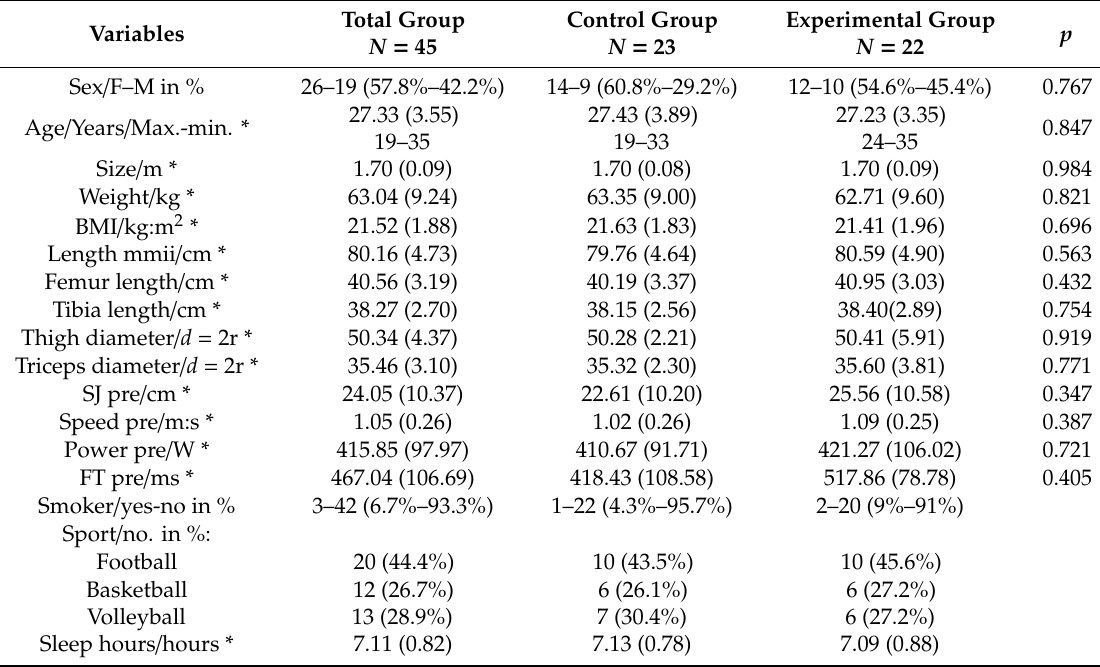
Table 1. Participants demographics and outcome measures at